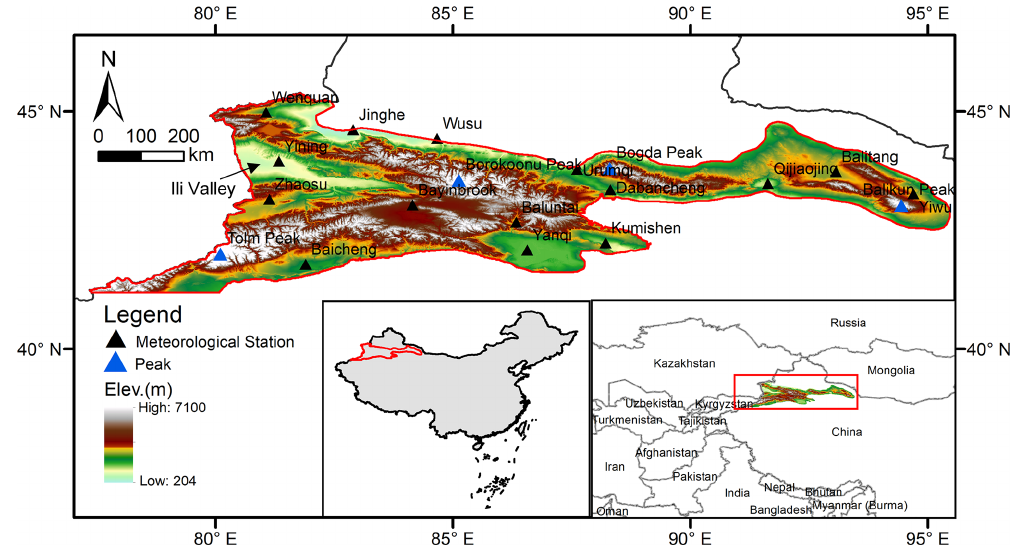
Figure 1. Location of the Chinese Tian Shan (CTM). The elevation ranges from 204m to 7100ma . s . l . , with a DEM resolution of 1km from SRTM. The grey map shows the extent of the CMA05 at the 0 . 5 ◦ × 0 . 5 ◦